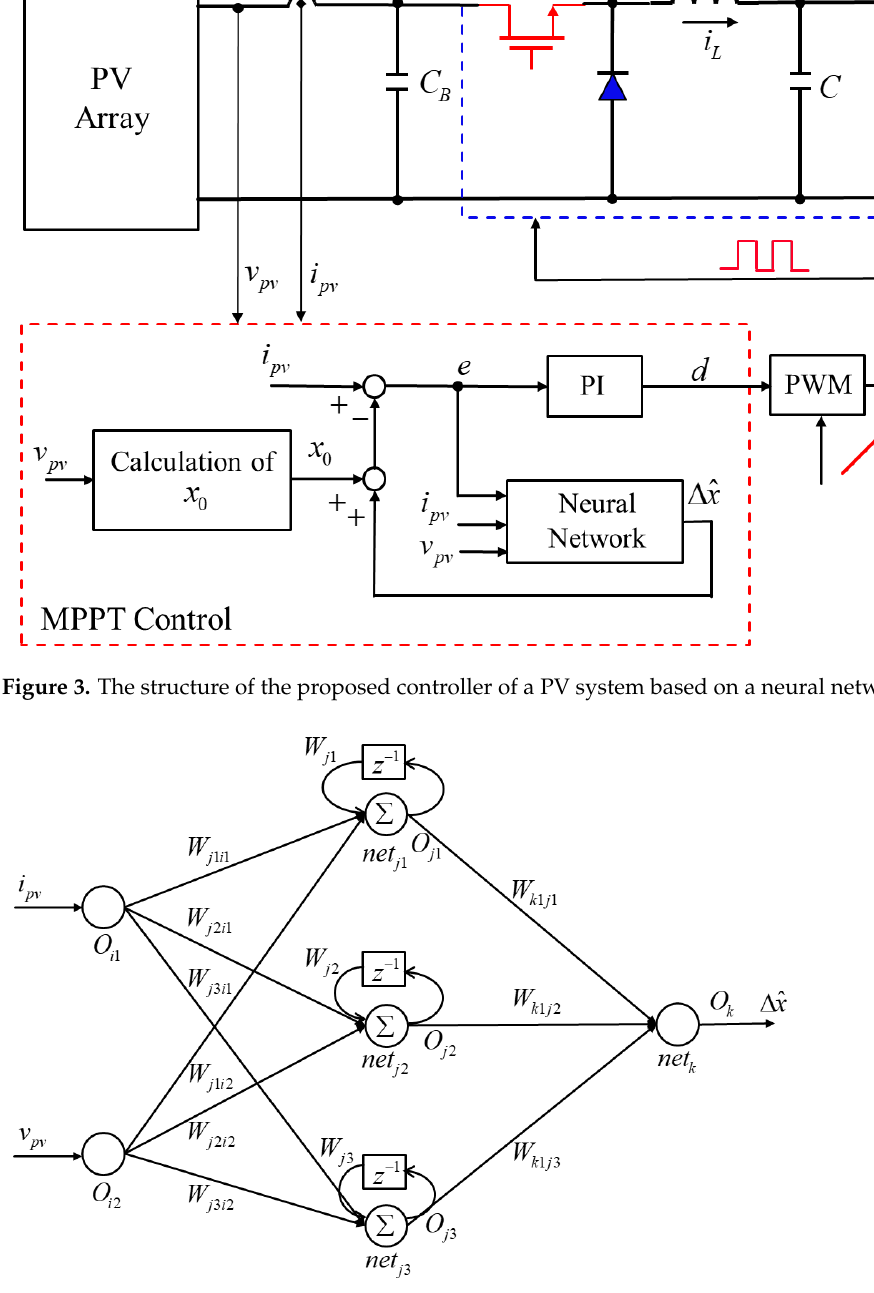
Figure 4. The structure of a recurrent neural network with two inputs pv i and pv v